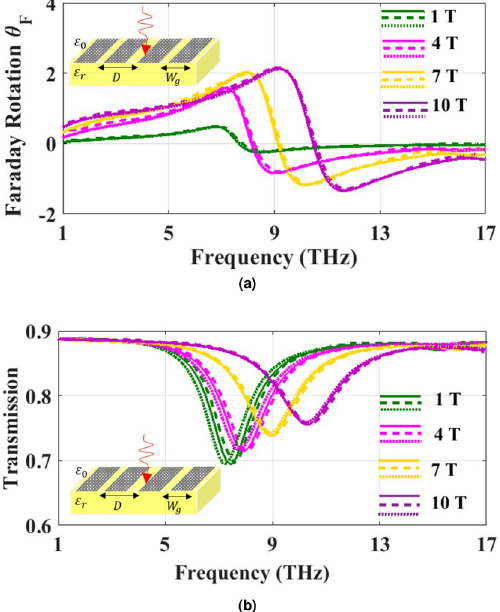
Figure 8. Comparison of ( a ) Faraday rotation angle and ( b ) transmission efficiency of the structure under study obtained using MoL (solid lines), those of Fourier-Floquet plane wave expansion method (dashed lines) and HFSS commercial software (dot lines) at different magnetic fields bias for µ c = 0.2 eV, τ = 0.1 ps and T = 300 K.